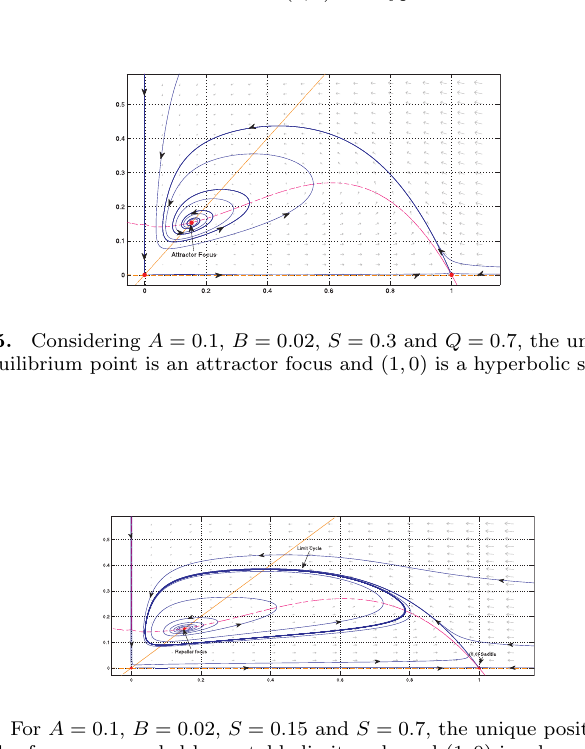
Figure 4. For A = 0 . 1 , B = 4 , S = 0 . 15 and Q = 0 . 7 . The positive equilibrium point is an attractor node and (1 , 0) is a hyperbolic saddle.